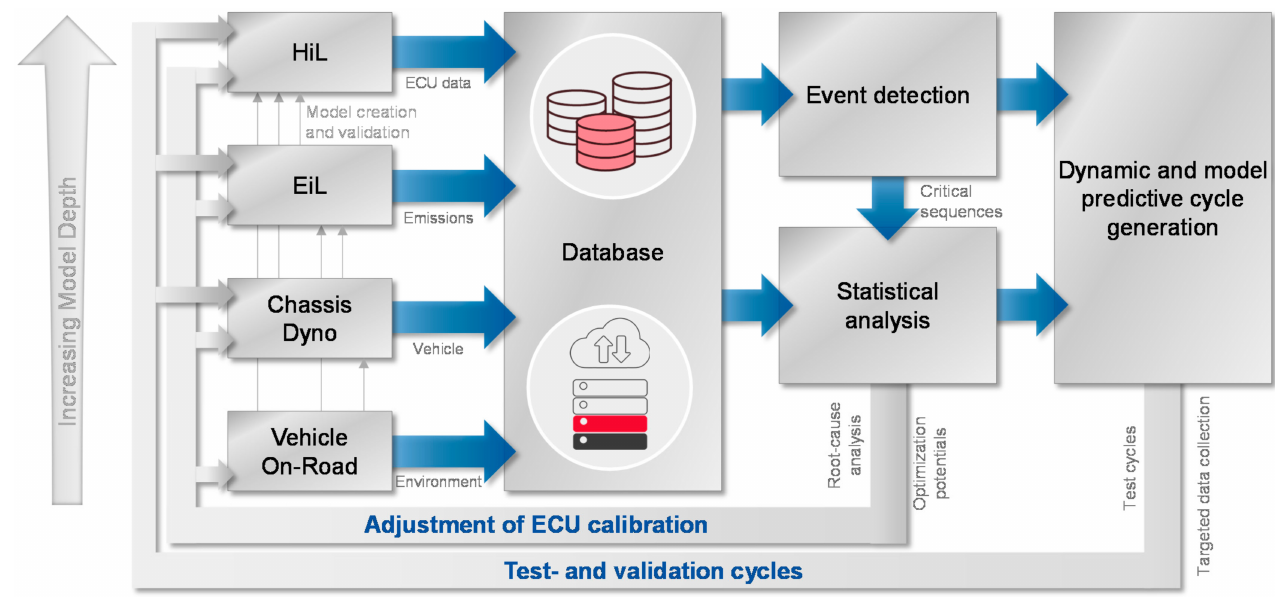
Figure 13. Concept for calibration and validation on multiple test bench